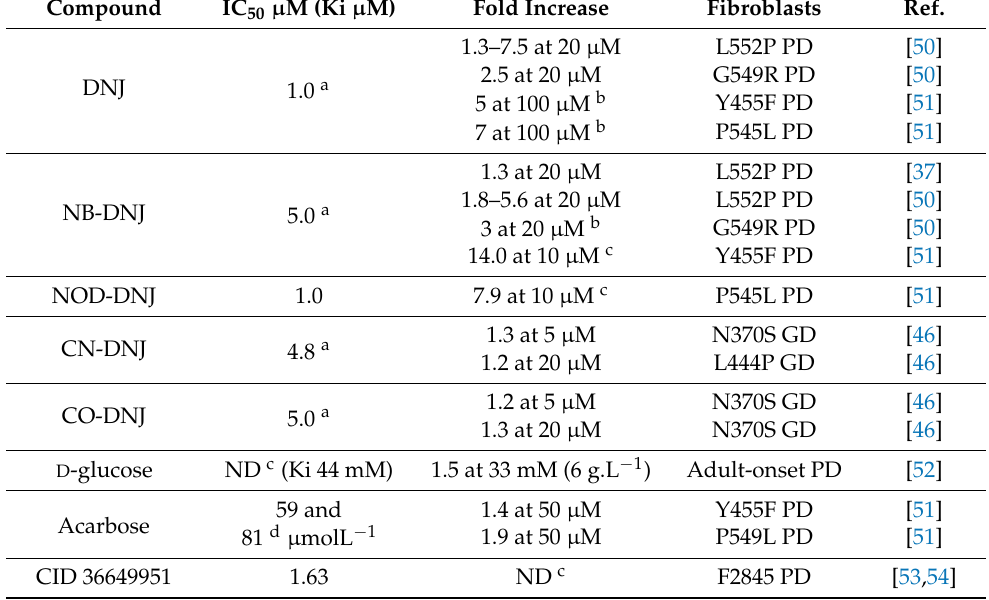
Table 1. ASSCs for